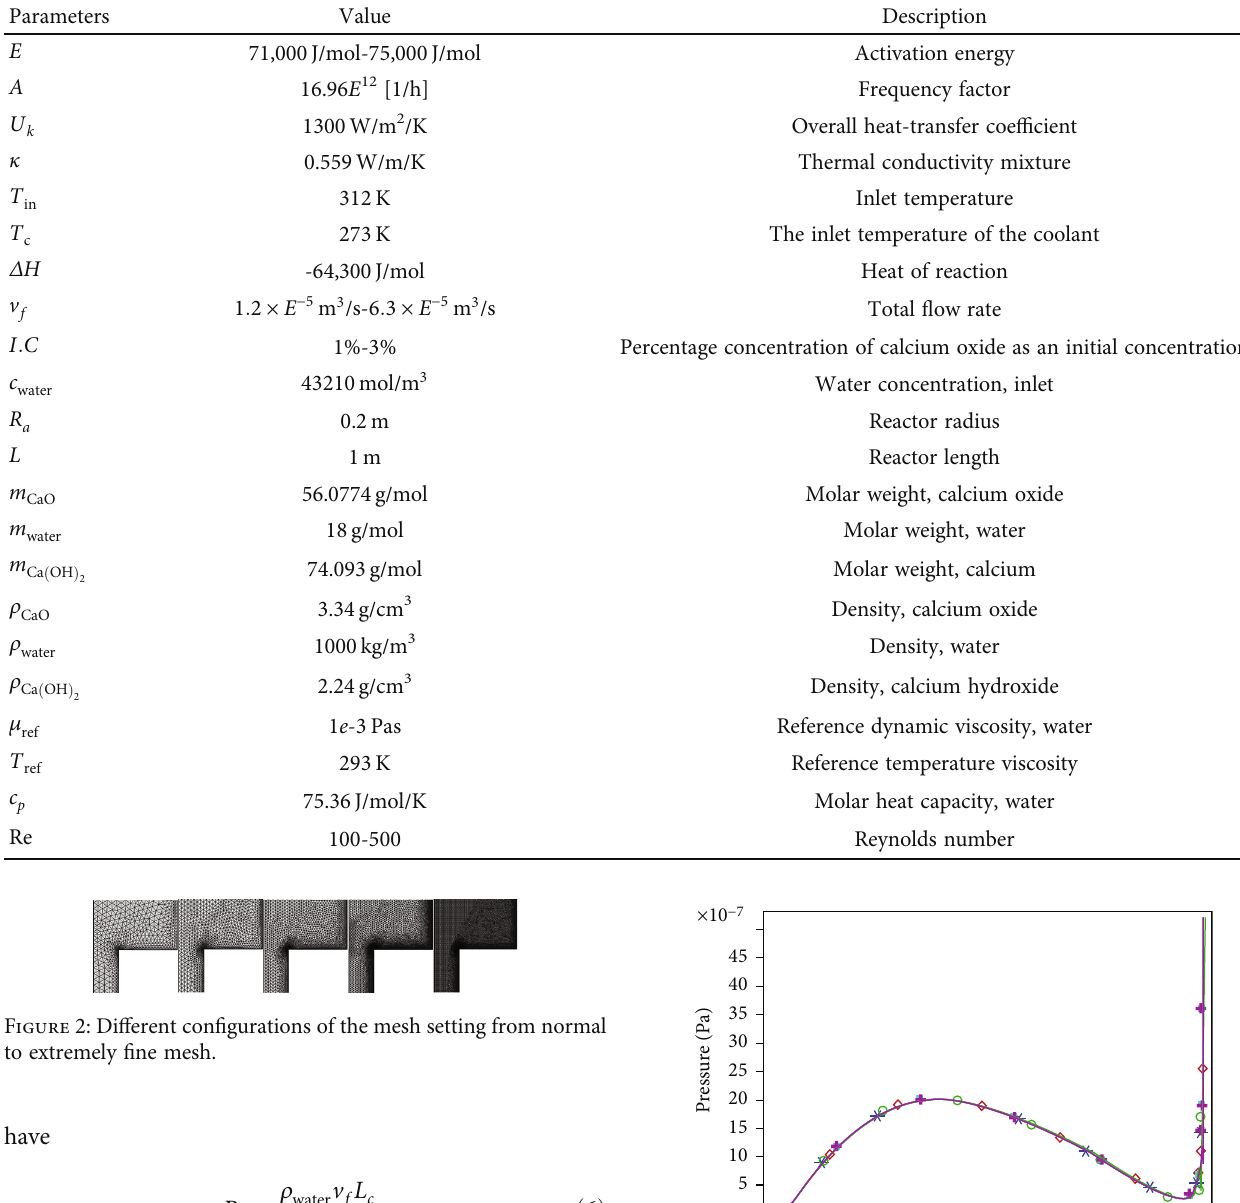
Table 1: Table of parametric selection.